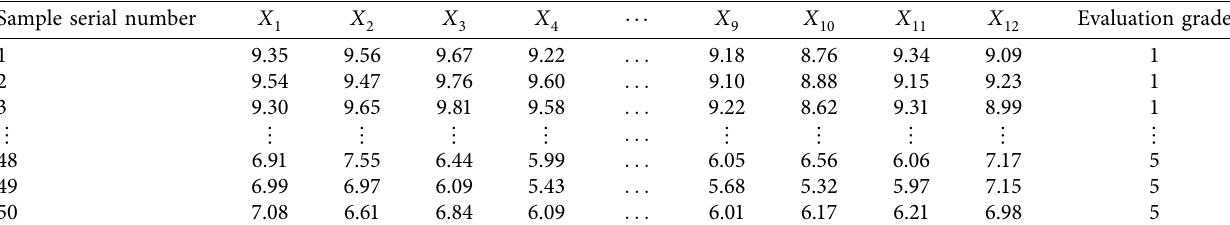
Table 3: Evaluation raw data.